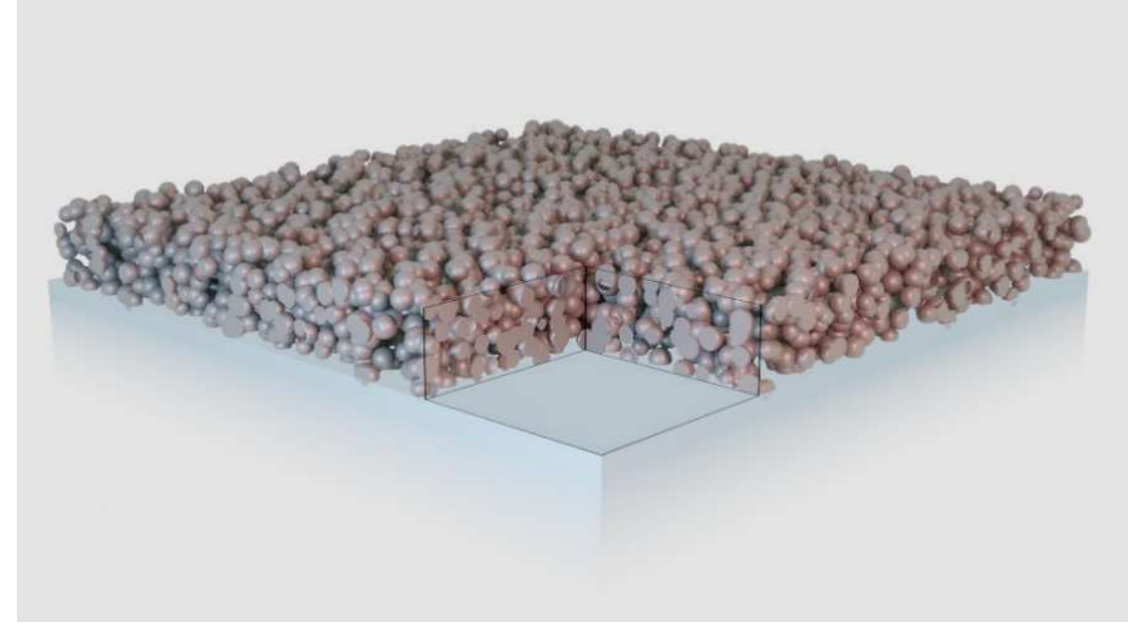
Figure 1. Schematic representation of an ultrathin porous film on a supporting substrate.